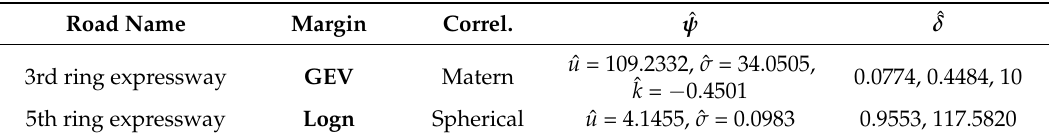
Table 3. Estimates of copula model parameters.